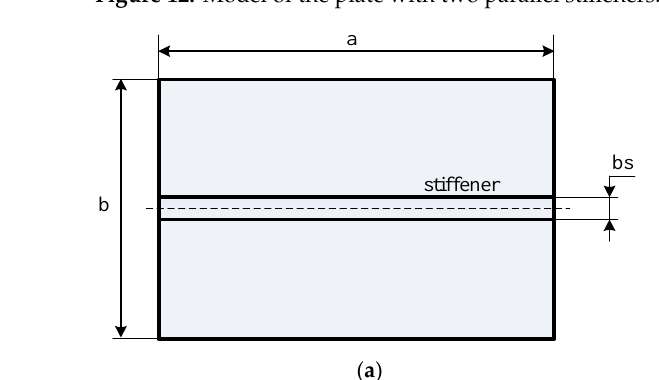
Figure 12. Model of the plate with two parallel stiffeners.